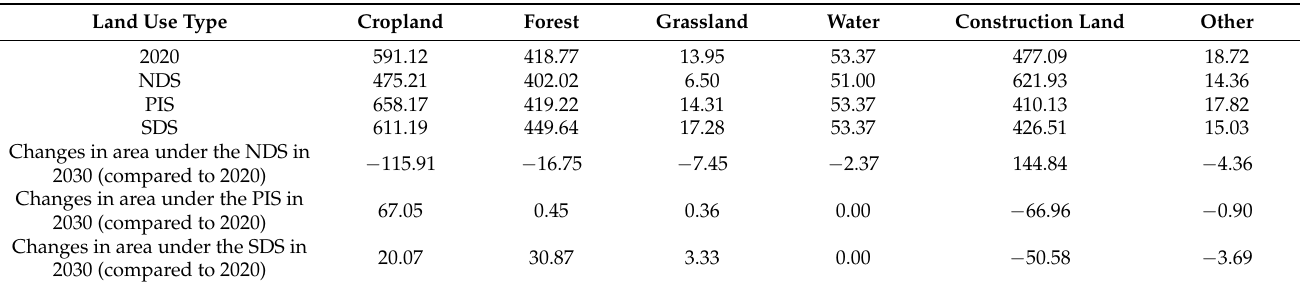
Figure 4. Three scenario simulation results in 2030: ( a ) NDS; ( b ) PIS; and ( c ) SDS. Table 5. Multi-scenario simulation of land use type change in 2030.